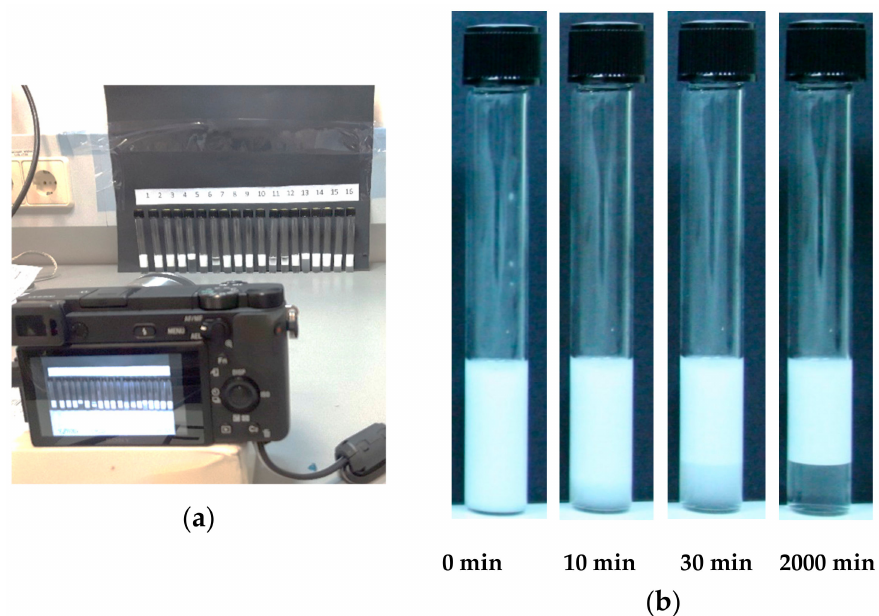
Figure 3. ( a ) Tracking phase separation in the emulsions inside multiple tubes by taking pictures at di ff erent time intervals with a camera (Sony a6300), ( b ) close-up of pictures of the same emulsion taken at di ff erent time intervals showing phase separation over time.